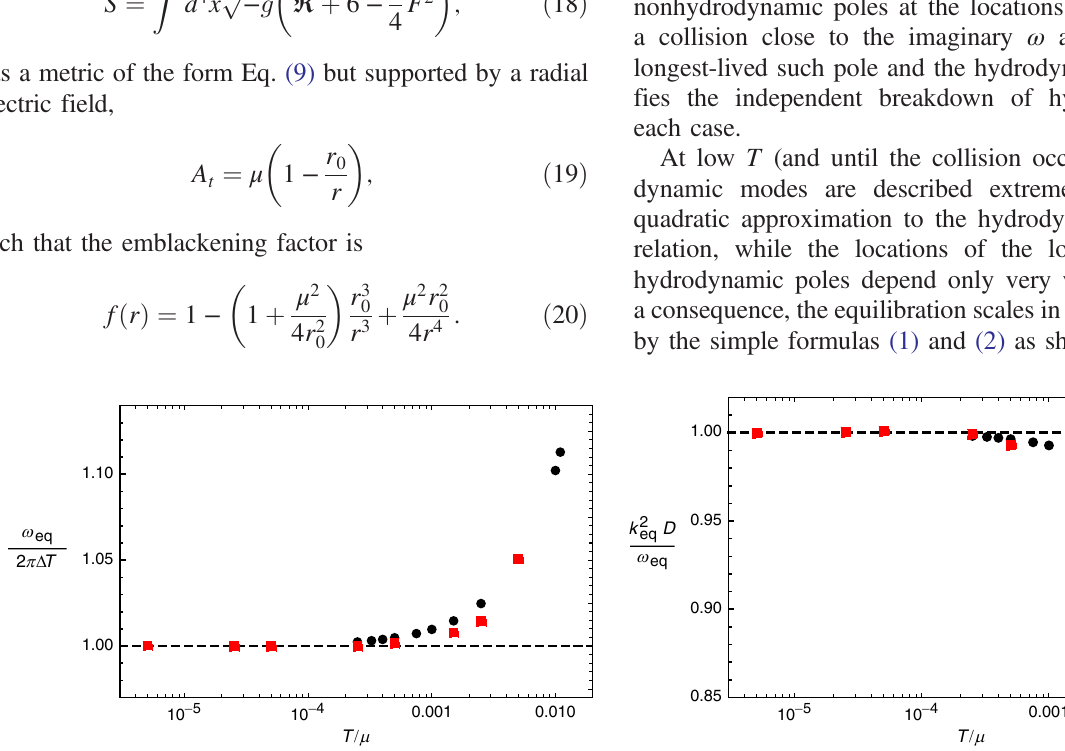
FIG. 5. Numerically obtained local equilibration data for diffusive hydrodynamics in G εε (black circles) and G ΠΠ (red squares) of the charged